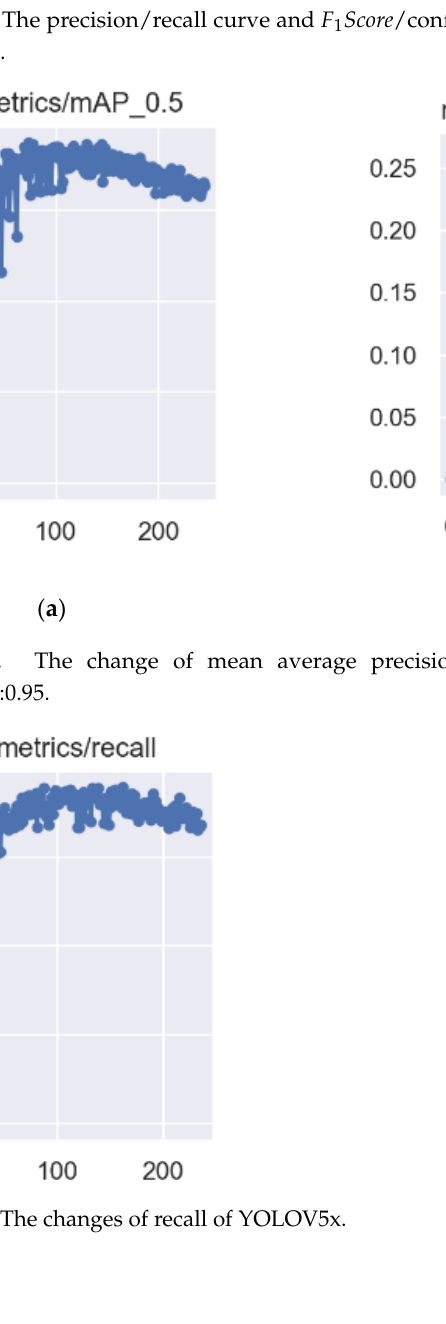
( b ) Figure A14. The precision/recall curve and F 1 Score /confidence curve of YOLOV5x: ( a ) PR_curve; ( b ) F1_curve. ( b ) Figure A15. The change of mean average precision (mAP) of YOLOV5x: ( a ) mAP_0.5; ( b ) mAP_0.5:0.95.